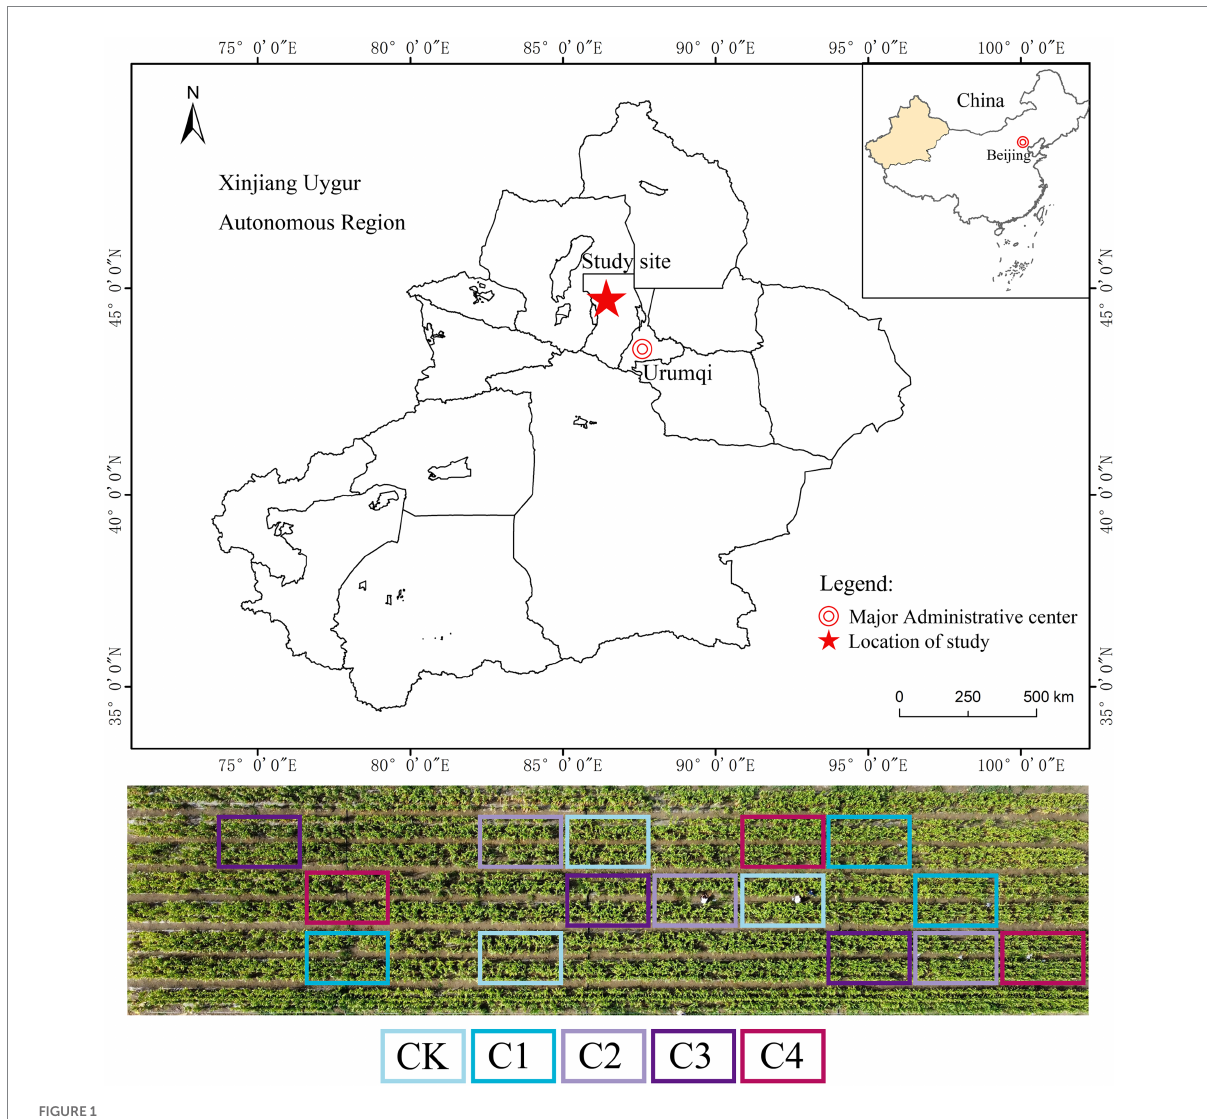
FIGURE 1 Study area within